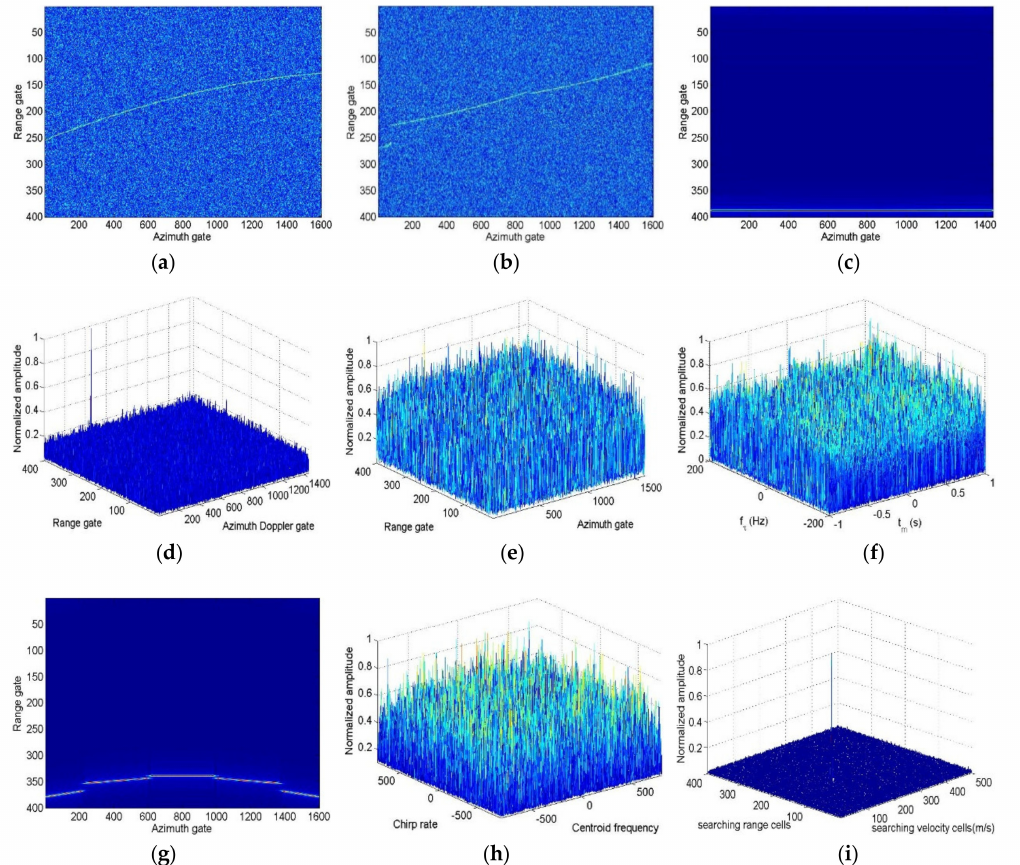
Figure 6. Refocusing results of different algorithms. ( a ) Range compression result. ( b ) Direct KT result. ( c ) Result after DPT and KT. ( d ) Focusing result of the presented algorithm. ( e ) Focusing result of MTD. ( f ) Focusing result of SOKT–GHHAF. ( g ) Result after TRT and SOKT. ( h ) Focusing result of TRT–SOKT–LVD. ( i ) Focusing result of